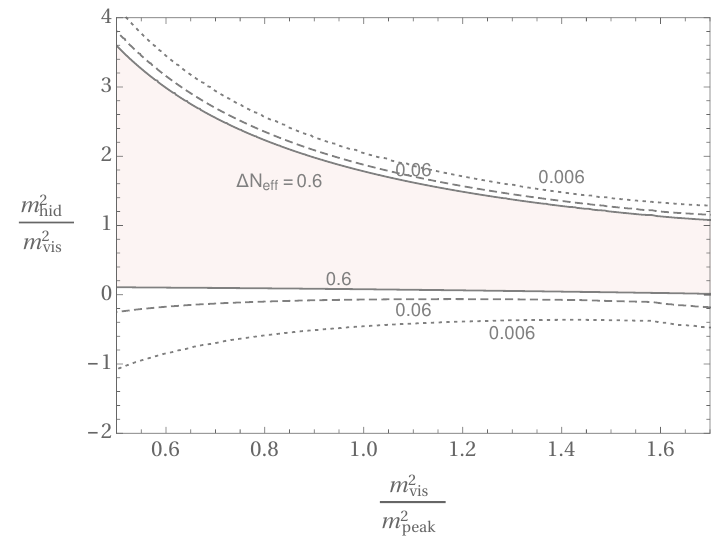
Figure 3 . Contours of the contribution to (cid:1) N e(cid:11) from a hidden sector with a (late-time) Higgs mass squared parameter m 2 , as the visible sector Higgs mass squared parameter m 2 hid